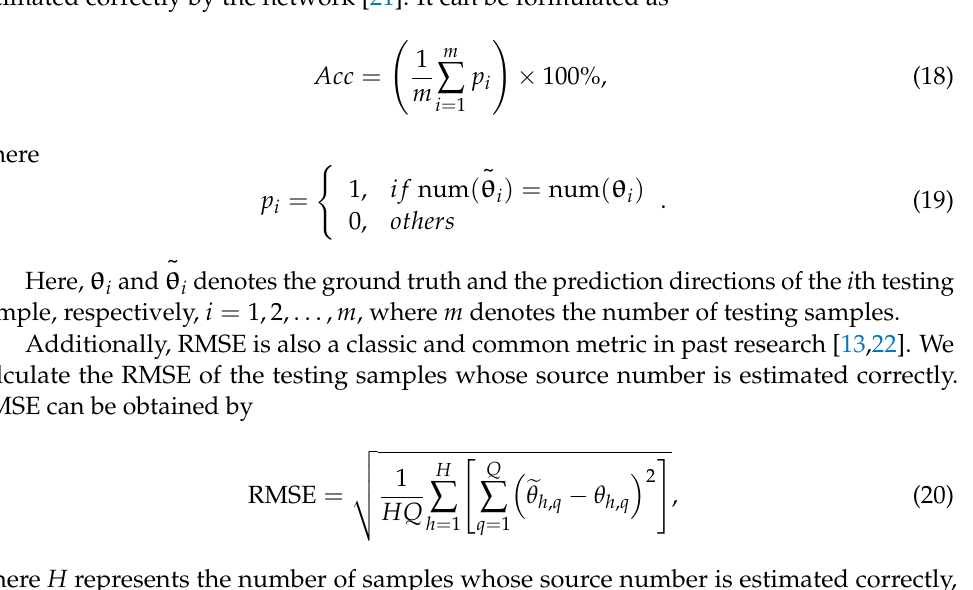
Table 2. The standard confusion matrix.